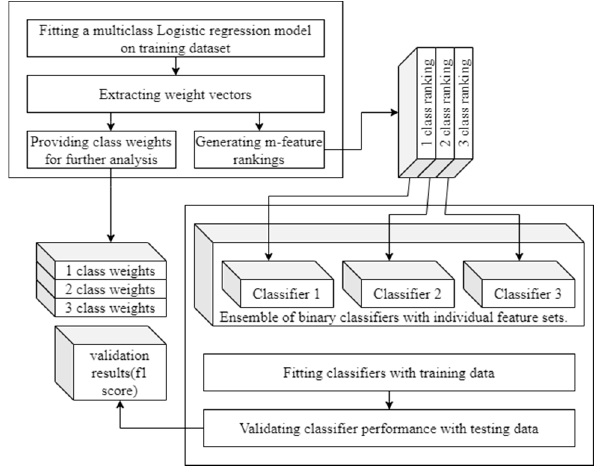
Figure 3. Feature selection experiment flowchart.